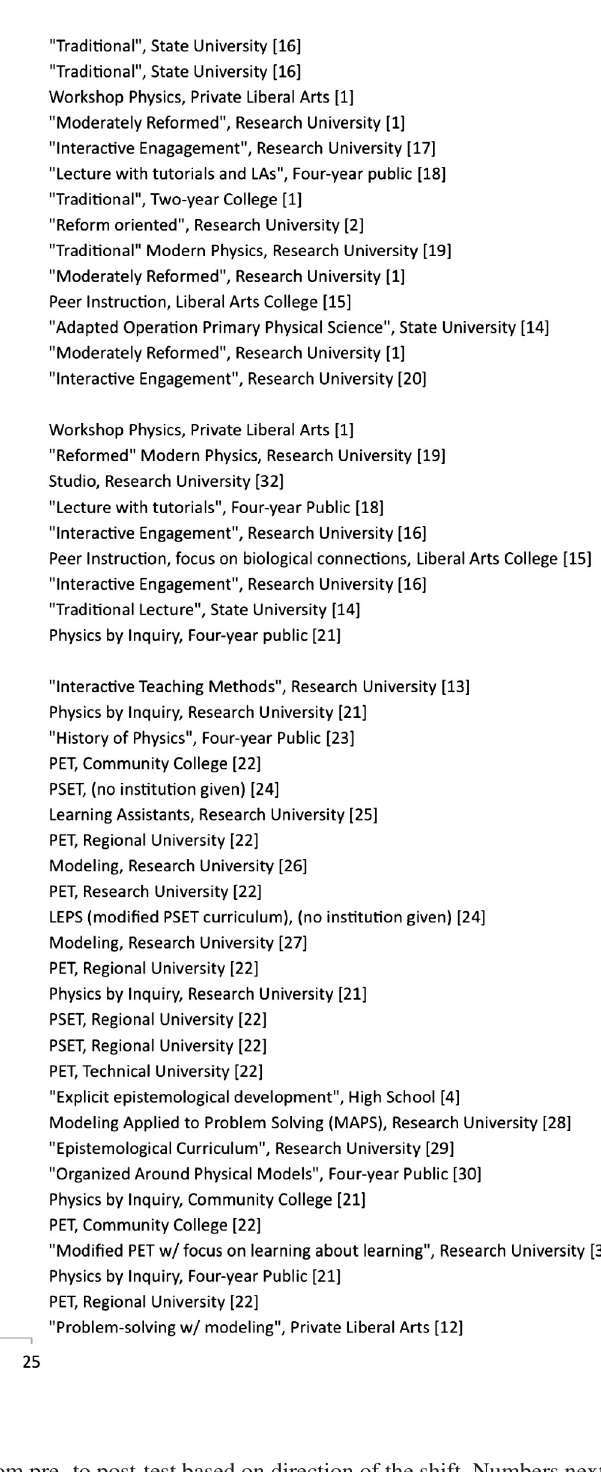
FIG. 1. Shifts in percent expertlike on CLASS or MPEX scores from pre- to post-test based on direction of the shift. Numbers next to bars indicate the number of students in the study. Error bars represent standard error. Error bars were not available for all studies. Green bars indicate that the MPEX or MPEX-II was used. In all other cases the CLASS was used. PET ¼ Physics of Everyday Thinking curriculum, PSET ¼ Physical Science of Everyday Thinking